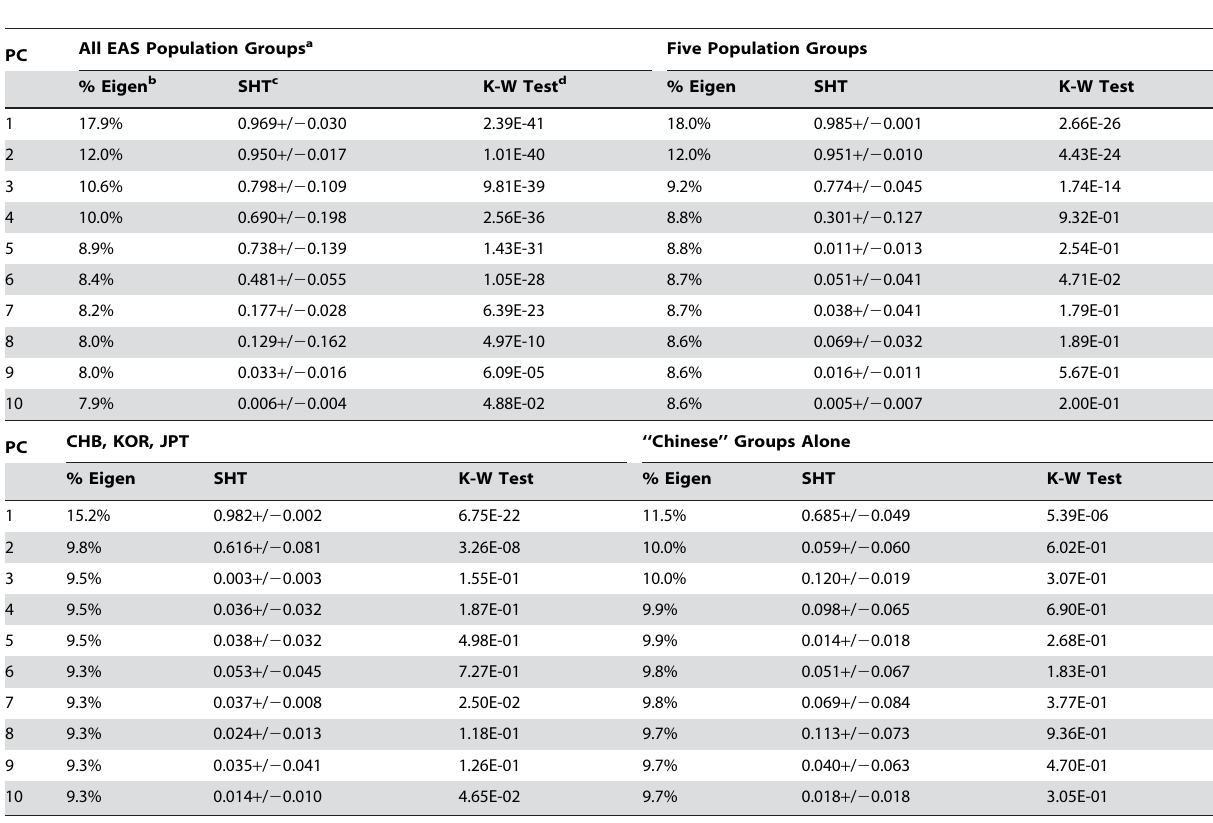
Table 2. Evaluation of Principal Components Analyses in East Asian Populations using 200 K SNPs.